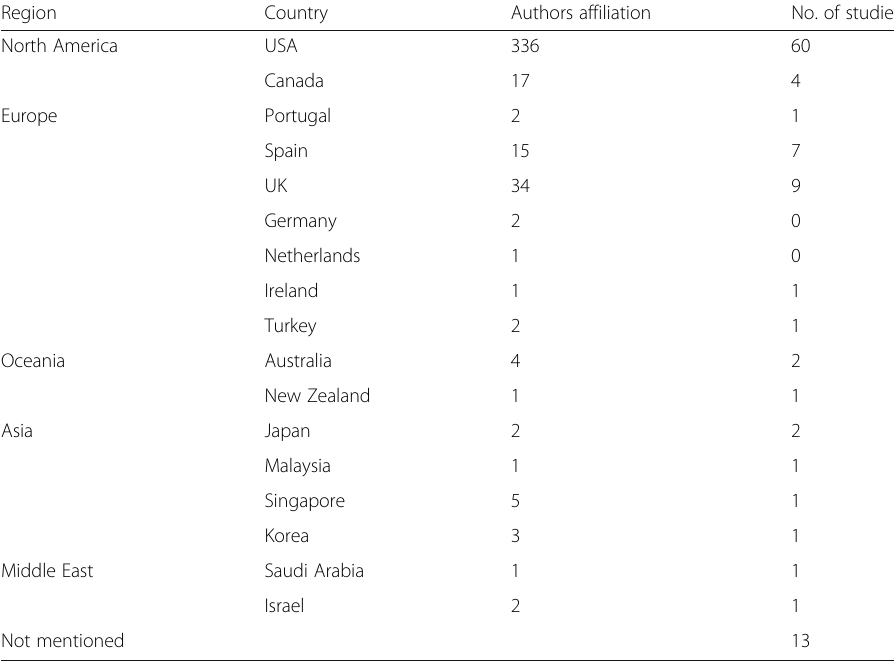
Table 2 Geographical distribution of author ’ s affiliation and study context Region Country Authors affiliation North